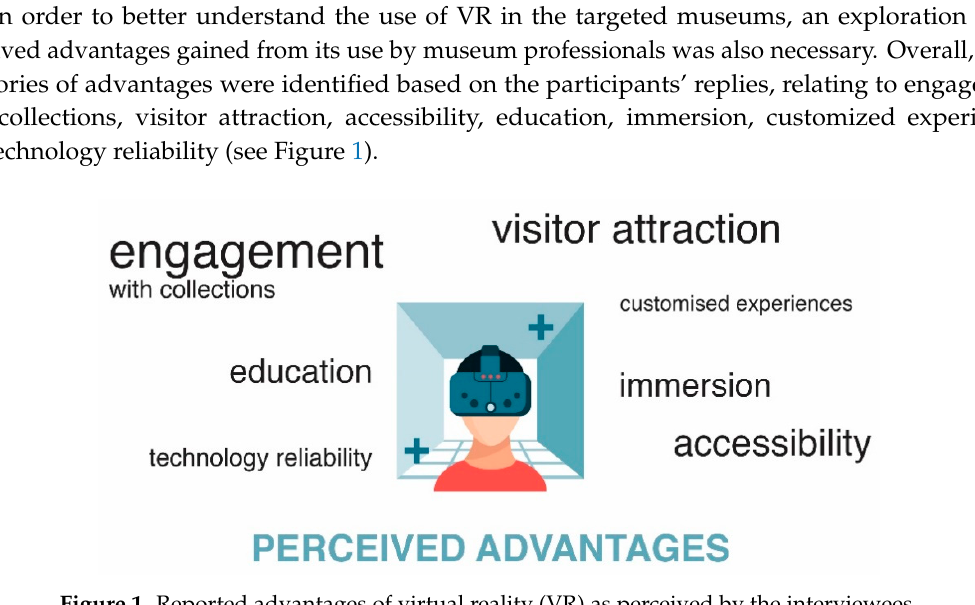
Figure 1. Reported advantages of virtual reality (VR) as perceived by the interviewees.